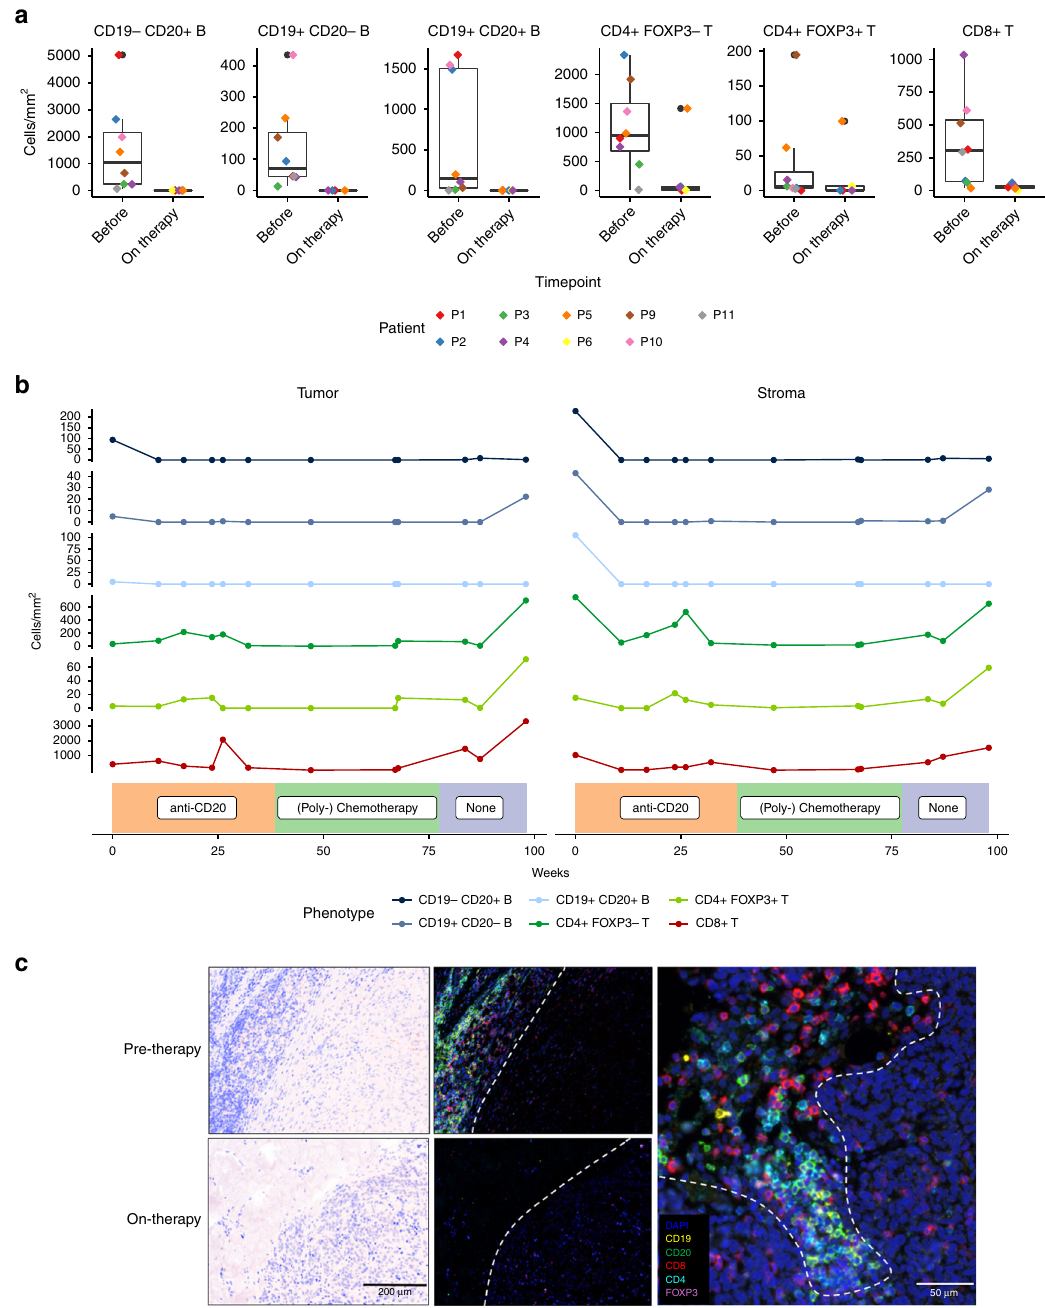
Fig. 6 Multiplex IHC con fi rms reduction of CD8 + and CD4 + T cells through B cell depletion. a B- and T cell numbers at the invasive tumor-stroma margin quanti fi ed using six-color multiplex immunostaining in tumor samples from nine patients obtained before and on therapy (at week 9 ± 2). Lower and upper hinges correspond to the fi rst and third quartiles, center line to the median. Upper whisker extends from the hinge to the largest value no further than 1.5 times the interquartile range. Other data points are shown as outliers (black circles). Individual patient values are shown through differently colored diamonds. b Longitudinal analysis of tumor samples obtained over nearly 2 years from patient 4. Sample regions were classi fi ed as invasive tumor-stroma margin (Stroma) and intratumoral (Tumor). The lowest panel depicts the respective therapy at the given timepoints. Line colors represent the respective cell types. c Multiplex immunostaining for indicated antigens (right) of a representative patient-matched pair of melanoma samples before (top) and on (down) anti-CD20 therapy. Images were taken at the invasive tumor-stroma margin (left: pathology overviews), separated by a dashed line (middle: corresponding immunostaining overviews). Close-up showing a dense B- and T cell in fi ltrate at the invasive tumor-stroma margin (right). Note loss of B and T cell in fi ltrates, but not tumor cellularity on therapy (left and middle, EBV-immortalized peripheral B cells and TAB, we included one further patient TAB 13,59 from tumor single-cell suspensions. From four patients, all these samples who was considered for but did not undergo anti-CD20 therapy. were successfully established, from a further patient EBV-immortalized peripheral In addition, of two patients with metastatic melanoma who were treated with B cells as well as EBV-immortalized TAB could be established. To increase the the anti-CD20 antibody rituximab in an adjuvant setting 41 (EudraCT number: number of patients with pre-therapy early passage melanoma cells and autologous